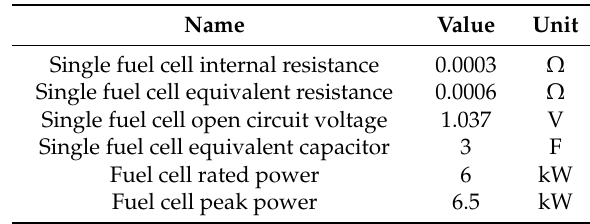
Figure 5. Output power-efficiency curve of fuel cell. Table 3. Fuel cell values.